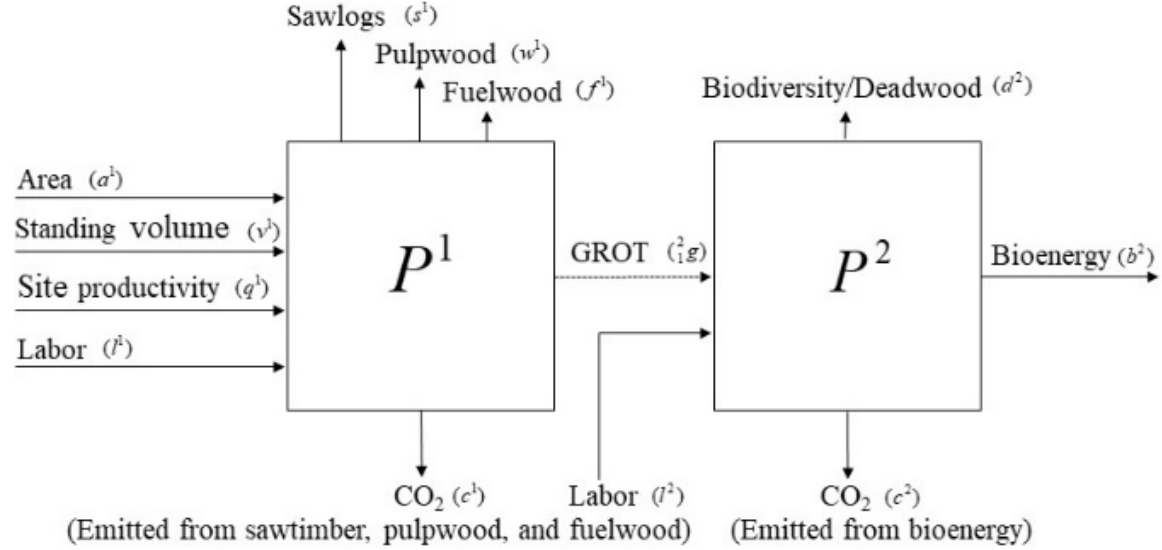
Figure 1. Two-technology network framework for the Data Envelopment Analysis (DEA) model. Note: GROT is harvesting residues.